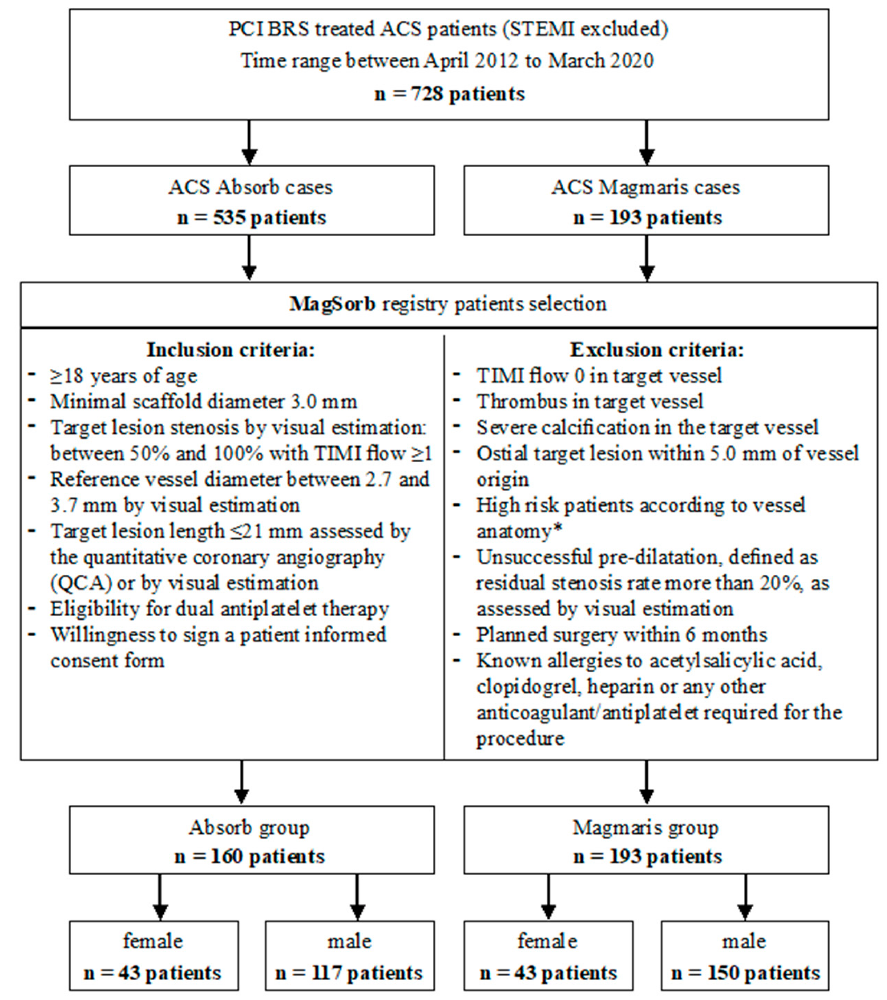
Figure 1. Study inclusion and exclusion criteria. PCI, percutaneous coronary intervention; BRS, bioresorbable scaffolds; ACS, acute coronary syndrome; STEMI, ST-segment elevation myocardial infarct; CABG, coronary artery bypass graft. * Left main disease or equivalent, three-vessel disease, or multi-vessel disease disqualification from CABG by local Heart Team.